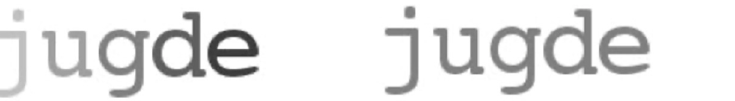
Figure 1. An instance of a graded gray format ( left ) and a homogeneous format ( right ) for the transposed-letter pseudoword jugde.